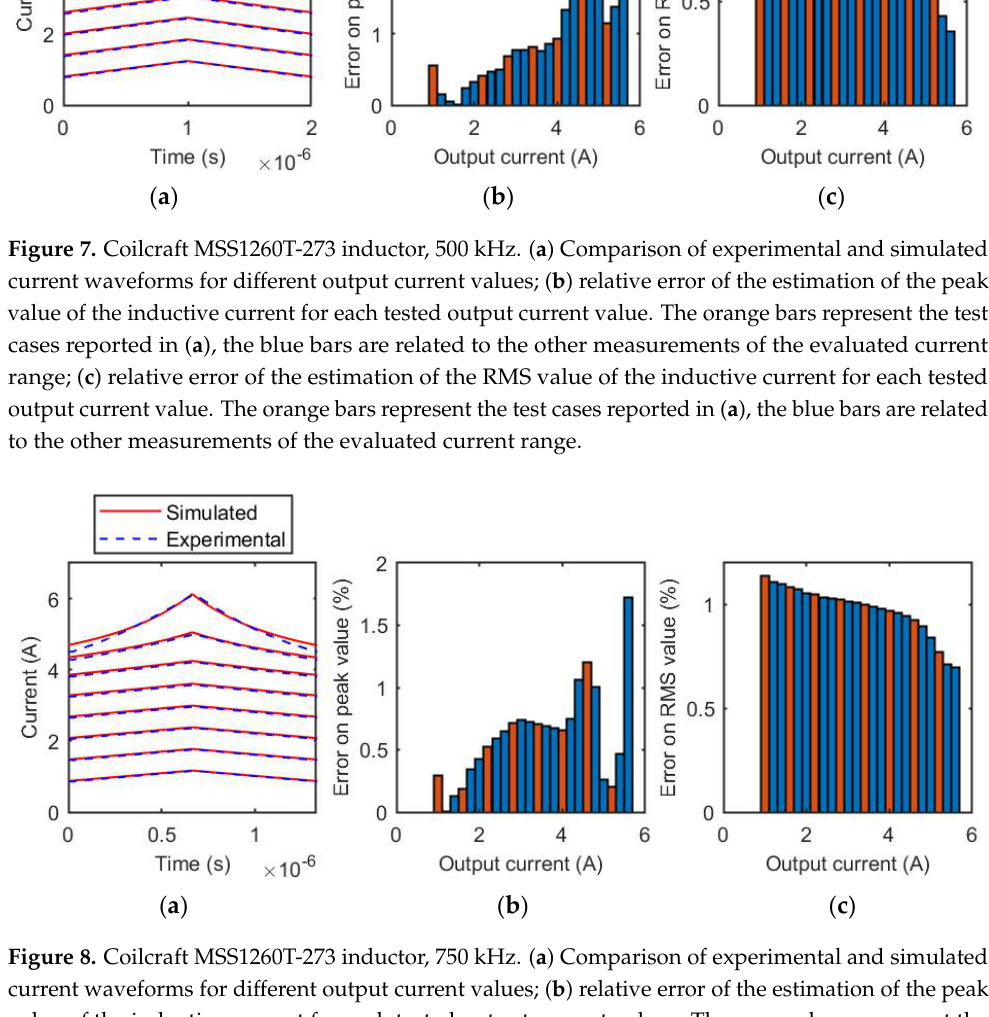
Figure 9. Coilcraft MSS1260T-273 inductor, 1 MHz. ( a ) Comparison of experimental and simulated current waveforms for different output current values; ( b ) relative error of the estimation of the peak value of the inductive current for each tested output current value. The orange bars represent the test cases reported in ( a ), the blue bars are related to the other measurements of the evaluated current range; ( c ) relative error of the estimation of the RMS value of the inductive current, for each tested output current value. The orange bars represent the test cases reported in ( a ), the blue bars are related to the other measurements of the evaluated current range. As the DC thermal steady-state characteristic is effective at different switching fre- quencies, a further verification was obtained by simulating currents measured under dif- ferent input voltages (12 and 32 V). The duty cycle was fixed at δ = 0.5 as it represented the maximum AC losses condition given the other specifications. The switching frequency was fixed at 500 kHz. Figures 10 and 11 show the comparison between measured and simulated current waveforms, followed by the relative errors of the RMS and peak value estimation.